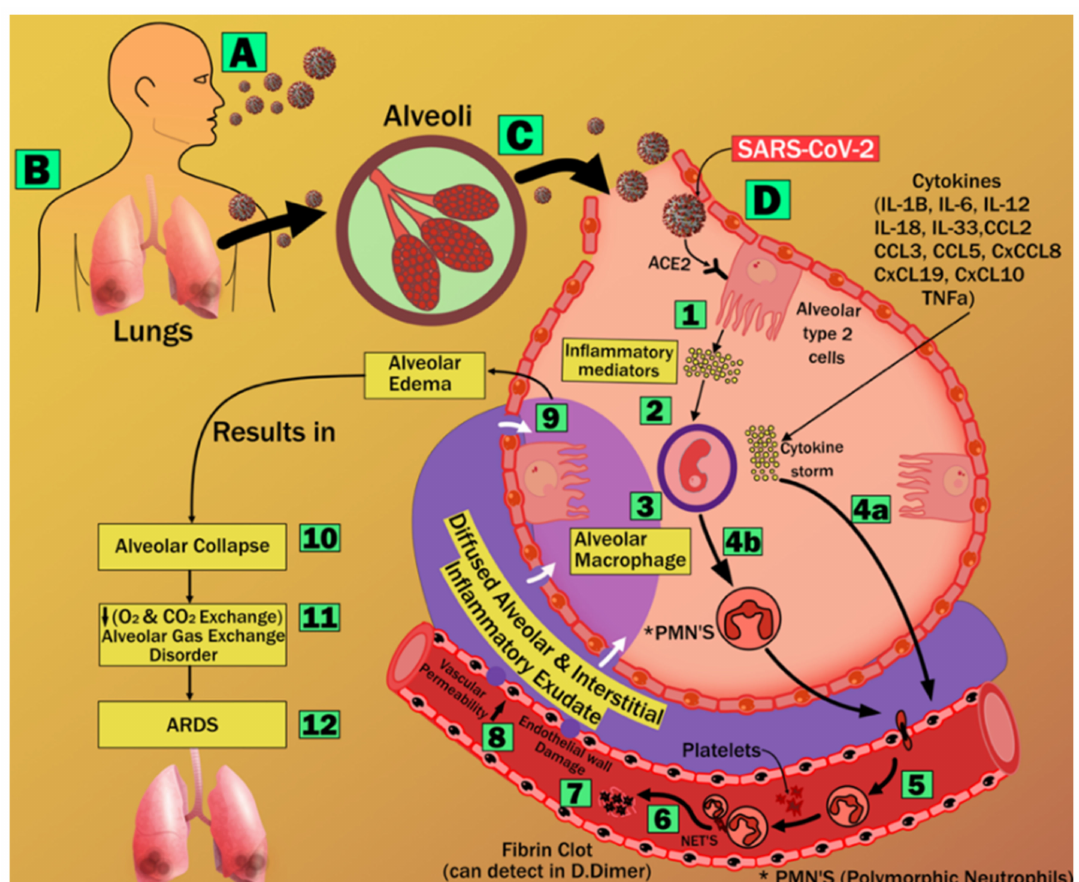
Figure 3. Stages of acute respiratory distress syndrome formation